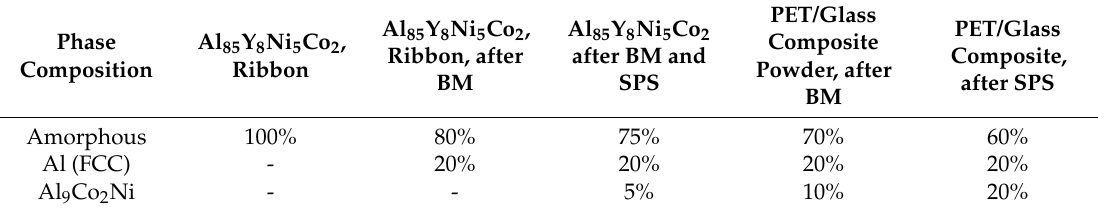
Figure 3. Differential scanning calorimetry (DSC) analysis of the Al 85 Y 8 Ni 5 Co 2 ribbon sample and polyethylene terephthalate powder sample ( a ), and thermal conductivity of pure PET samples, Al 85 Y 8 Ni 5 Co 2 metallic glass, and composite samples ( b ).